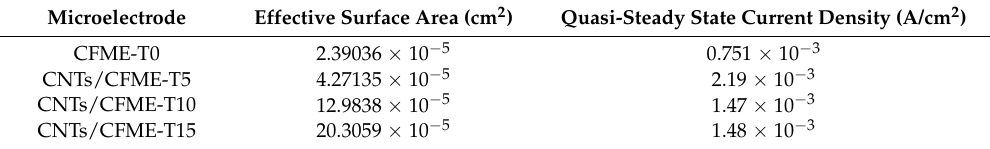
Table 3. The effective surface area and quasi-steady state current density of the as-prepared microelectrodes.